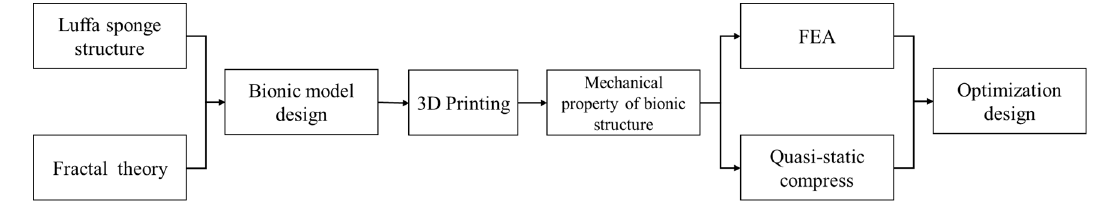
Figure 2. The flow chart of bionic research.